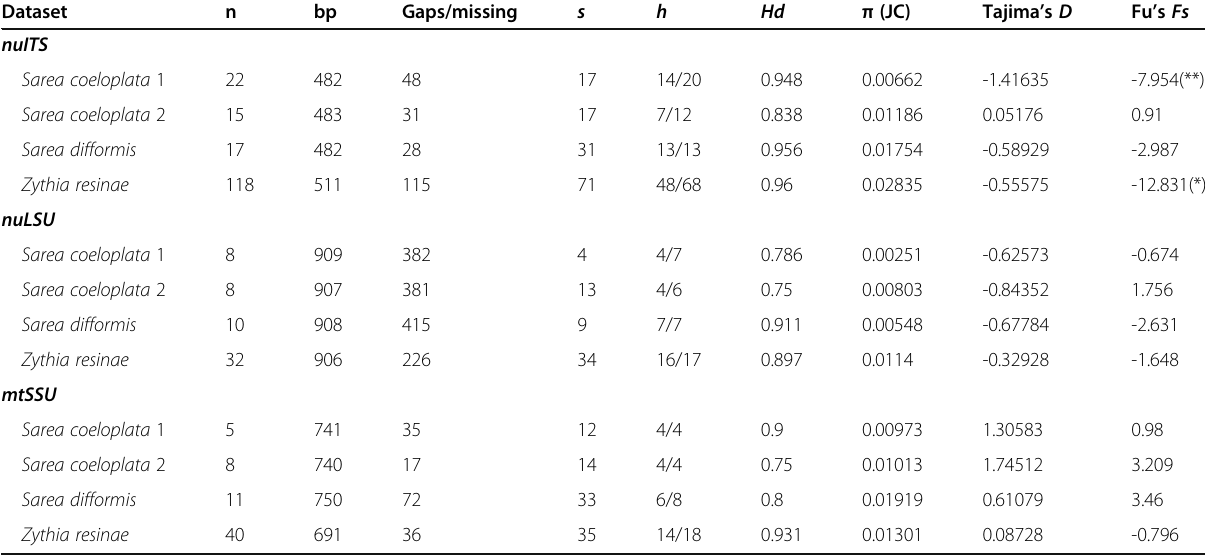
Table 2 Polymorphism statistics and neutrality tests for Sarea spp. and Zythia resinae Dataset n bp